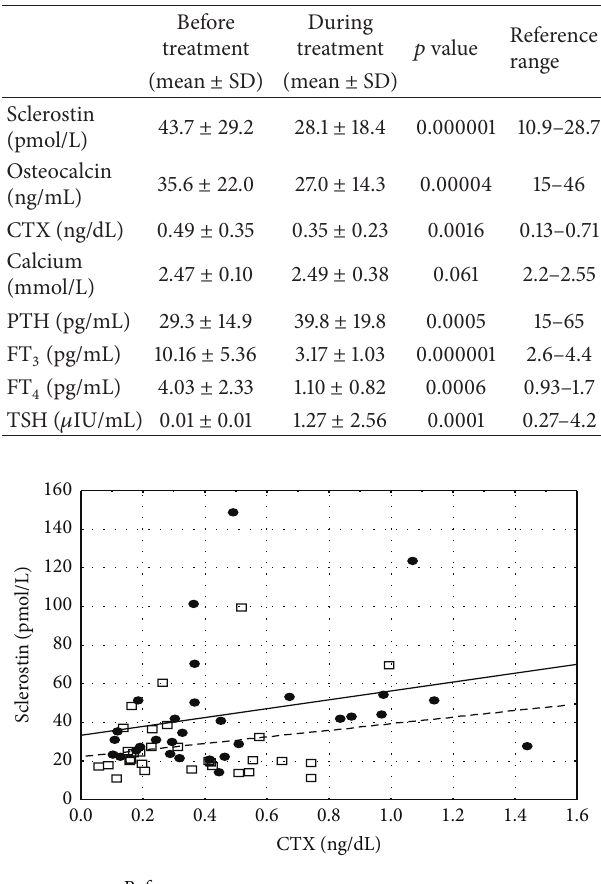
Table 2: Comparison of distributions of selected parameters before and during treatment ( 𝑝 value of Wilcoxon’s matched pairs test).